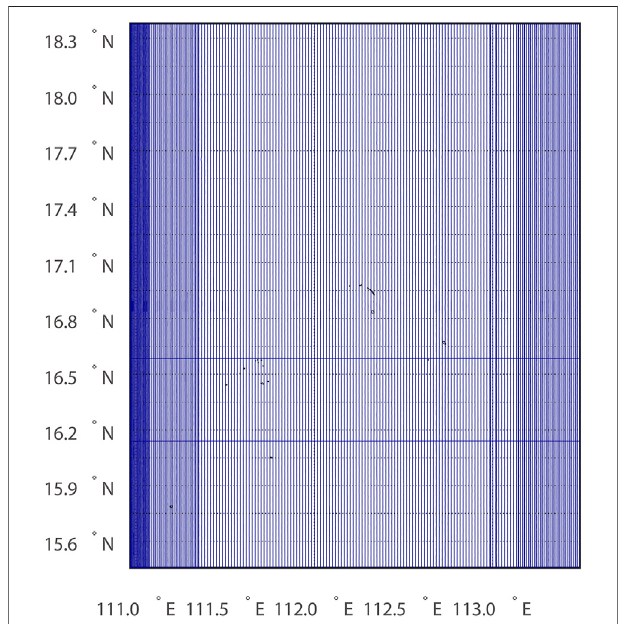
FIGURE 3 | Flight lines of airborne gravimetric survey over the Paracel Islands.